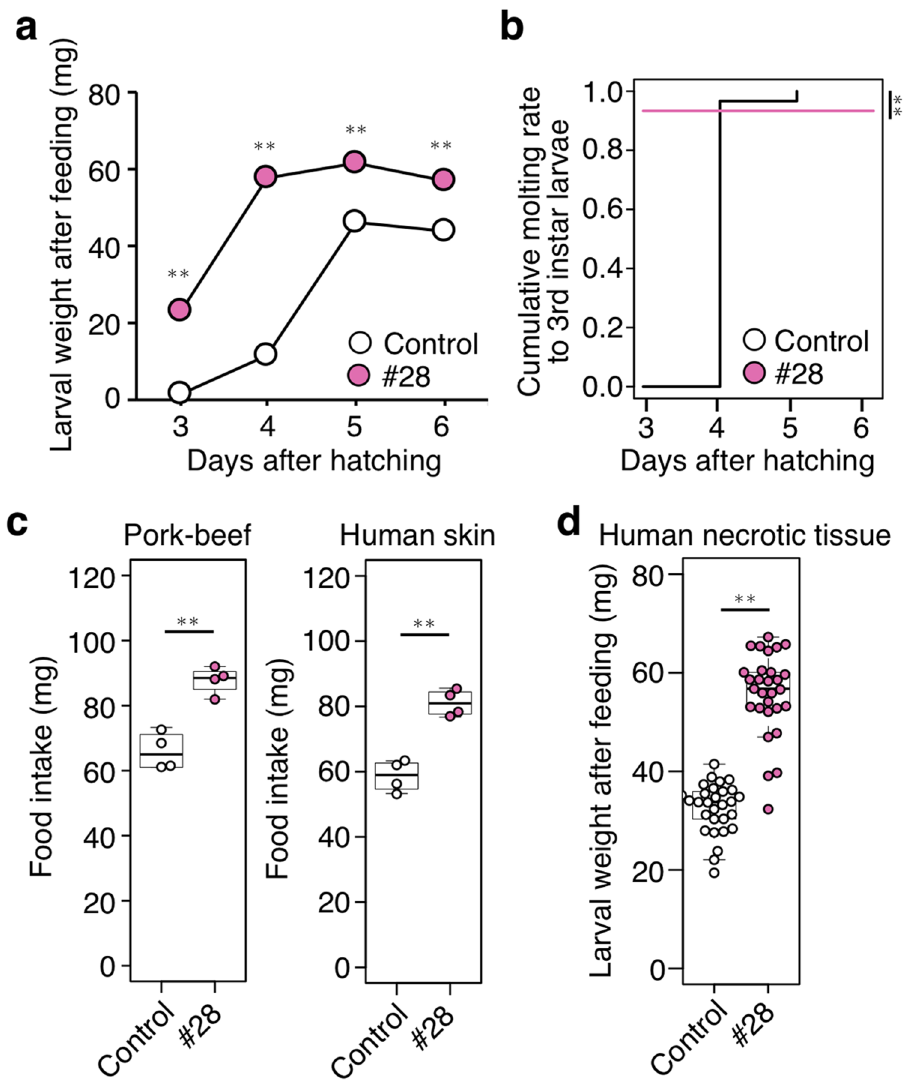
Figure 4. A corpse-derived fly strain that ingested human tissue effectively. ( a , b ) Weight ( a ) and developmental rate (third instar larvae) ( b ) of larvae supplied with 18 g of pork-beef mince. n = 40 per group. The mean values are shown ± SEM in ( a ). Student’s t -test ( a ), two-sided log-rank test ( b ). ** p < 0.01. ( c ) Amount of food intake by larvae at 5 days after hatching supplied with 6 g of pork-beef mince (left) or human skin mince (right). n = 4 per group. ( d ) Weight of larvae at 5 days after hatching supplied with 18 g of human necrotic tissue mince. n = 30 per group. In ( c ) and ( d ), each dot represents the value of an individual larva. Boxplots: center line, median; box range, 25th–75th percentiles; whiskers denote minimum–maximum values. Student’s t -test, ** p < 0.01. See also Supplementary Data 1 for data of experiment, exact sample sizes, and p